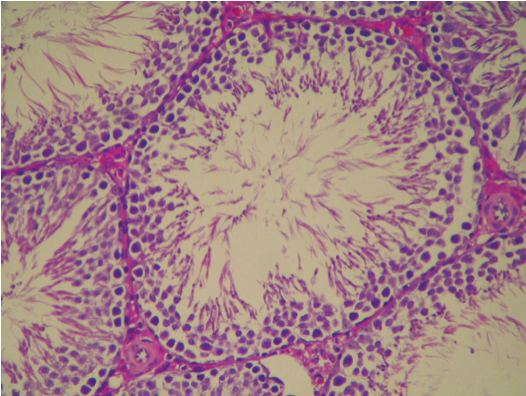
Figure 1 - Histological sections of rat testes stained with hematoxylin and eosin. Full spermatogenesis is seen in control group (H-E,